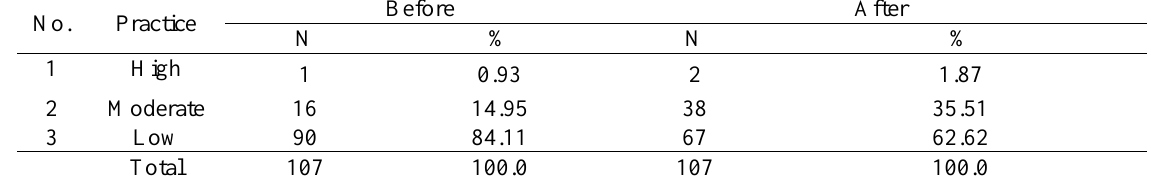
Table 3. Differences in practice of respondents pre- and